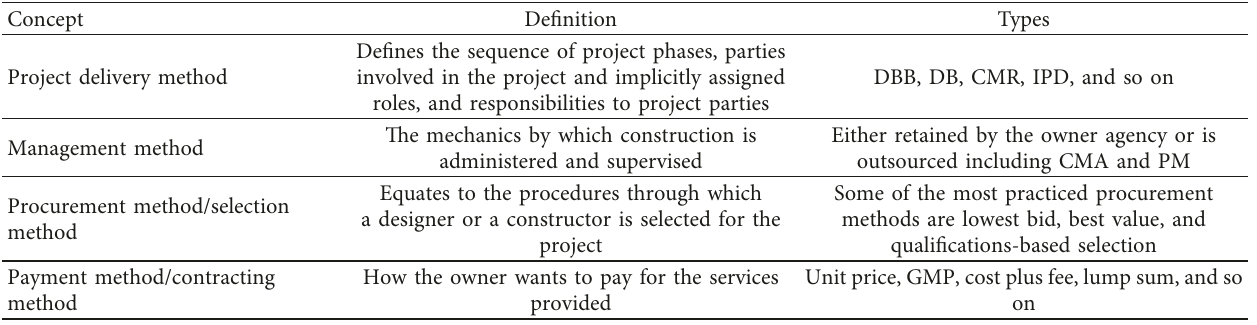
Table 1: Comparison of the PDM with other related